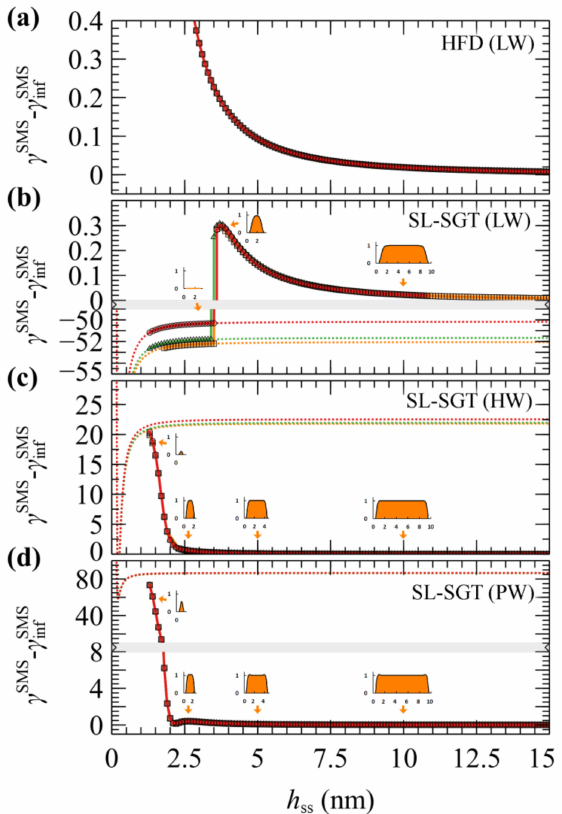
Figure 6. Potential of mean force, in mJ/m 2 , for the system of approaching bare silica surfaces in a melt (SMS) obtained by the ( a ) HFD, ( b ) SL-SGT (LW), ( c ) SL-SGT (HW) and ( d ) SL-SGT (PW), for N m = 24 (red), 96 (green), and 384 (orange). The calculations were performed in a decremental fashion, in which w (cid:48) ifc,init ( h ss ) = w (cid:48) ifc,final ( h ss + ∆ h ) , with a compression rate equal to − 0.1 nm/evaluation. The inset graphs in (b-d) depict snapshots of the density profiles at plate-plate distances denoted by the arrows, for N m = 384. Bands denote scale changes along the axes. The dashed lines display the Hamaker potential contribution to the solid–solid interaction, shifted by twice the solid/polymer adhesion